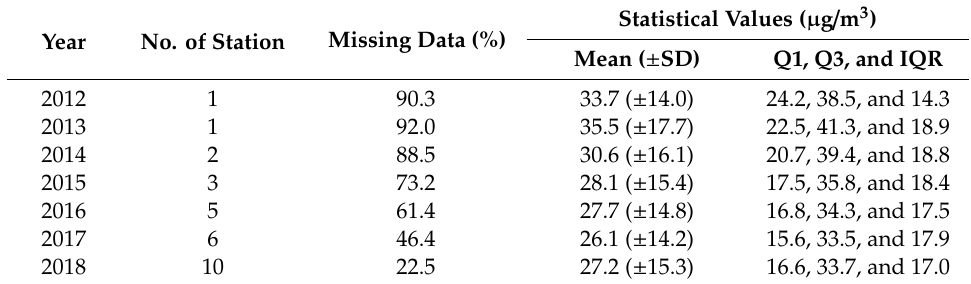
Table 1. Descriptive statistics of PM 2.5 measurements in Bangkok during